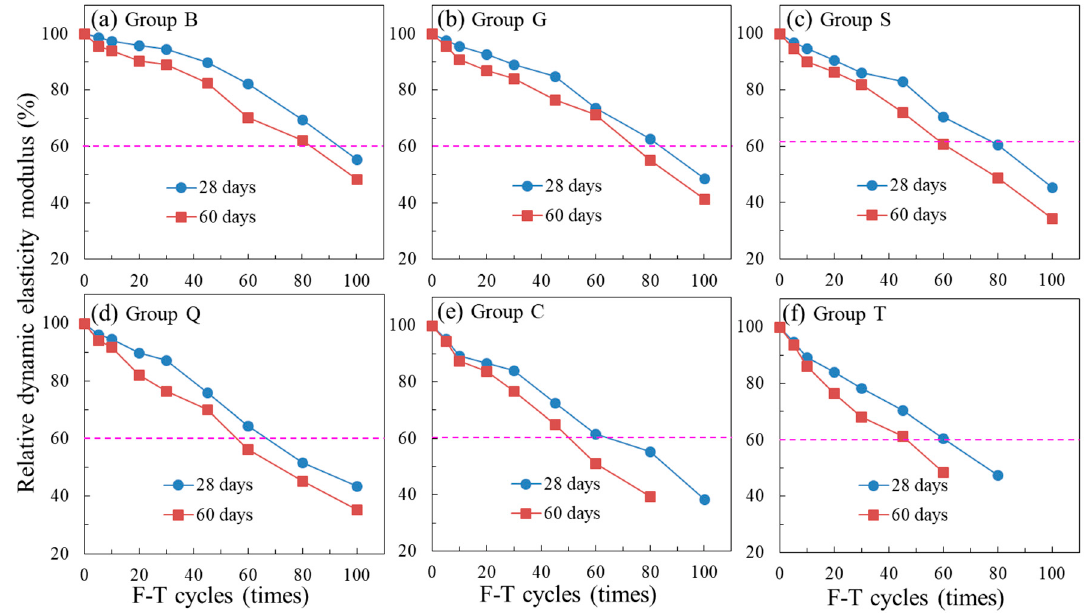
Figure 12. The relative dynamic elasticity modulus of new-to-old concrete under F-T cycles: ( a ) Group B, ( b ) Group G, ( c ) Group S, ( d ) Group Q, ( e ) Group C, ( f ) Group T.